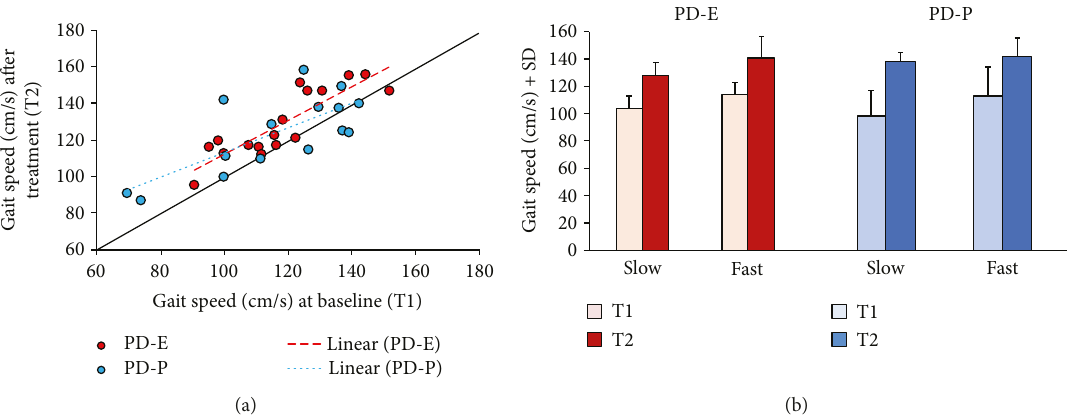
Figure 6: (a) This shows the correlation between gait speed pre- and posttreatment, as assessed by baropodometry. Red and blue circles represent all single subjects of the PD-E and PD-P groups, respectively. Most data points lay above the identity, indicating increased walking speed in most patients. (b) The patients with a lower gait speed at T1, belonging to both treatments groups, did not show a statistically signi fi cant disproportionate improvement after